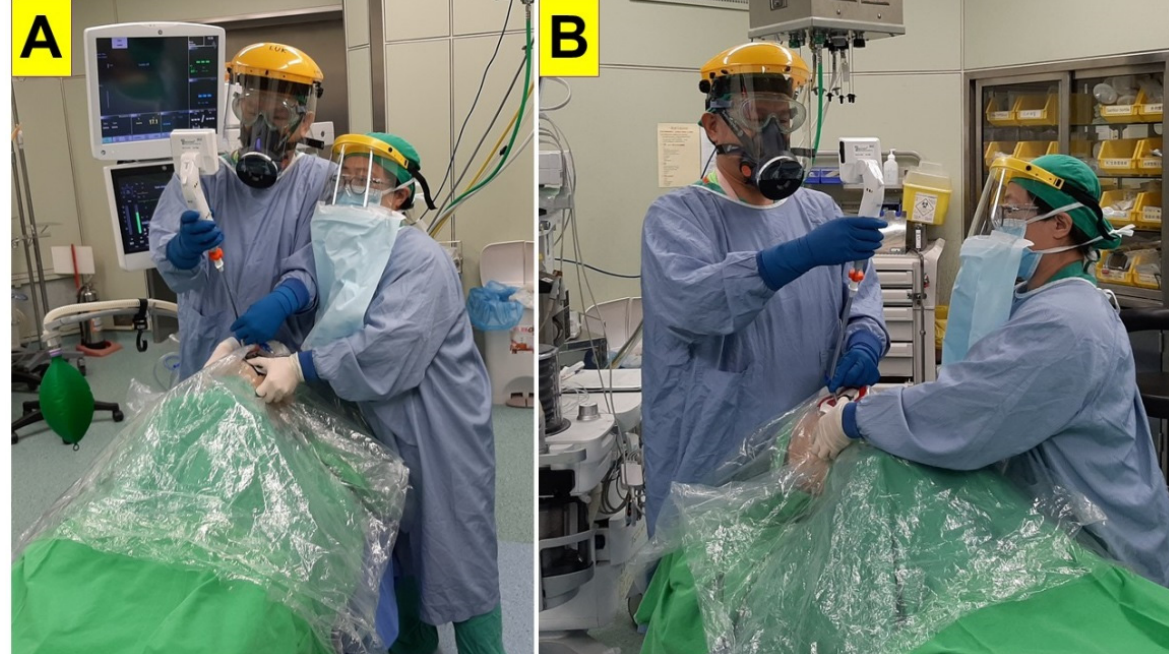
Figure 9. Endotracheal intubation utilizing a video intubating stylet with an assistant providing mouth opening and jaw lift over a plastic sheet barrier. The assistant stood either by the side of the intubator ( A ) or in the caudal direction ( B ).